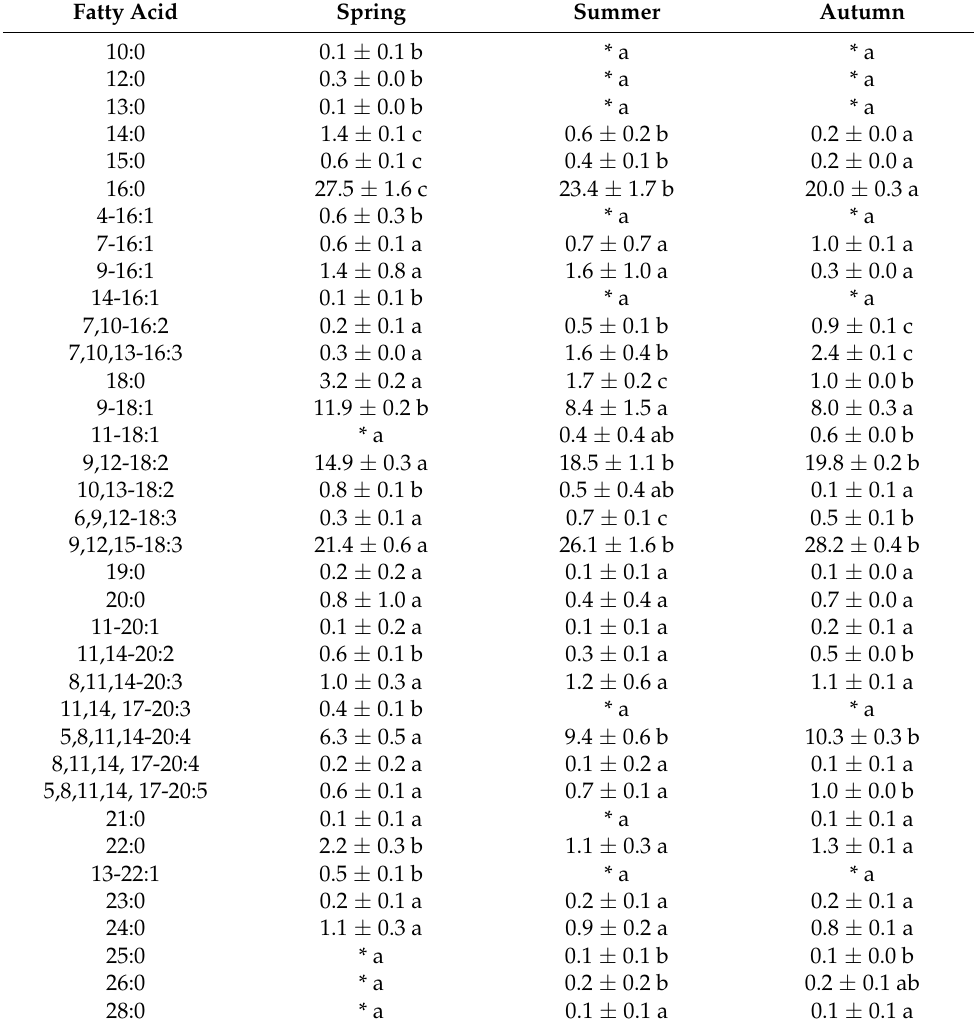
Table 1. Lipid fatty acid composition of Asplenium scolopendrium fronds in spring, summer, and autumn (mass % of the amount of